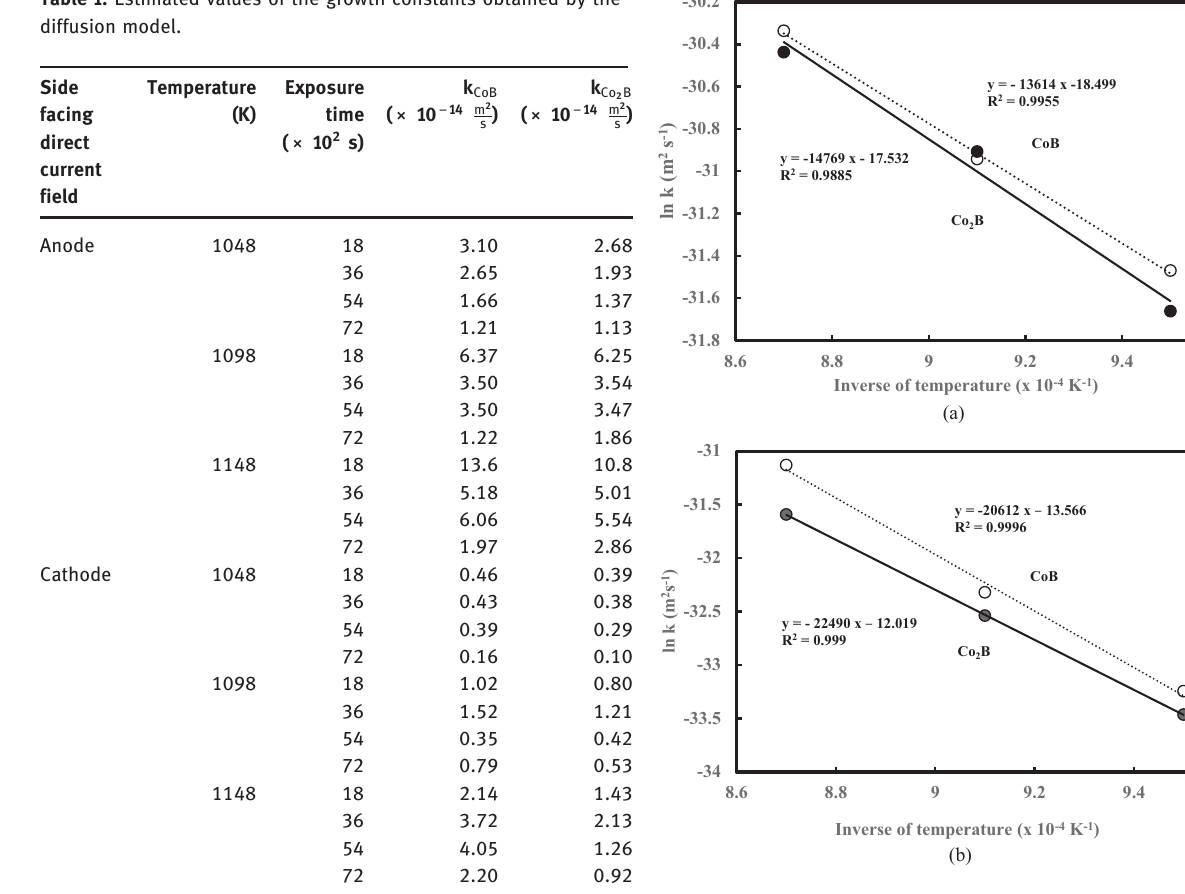
according to the 2 B